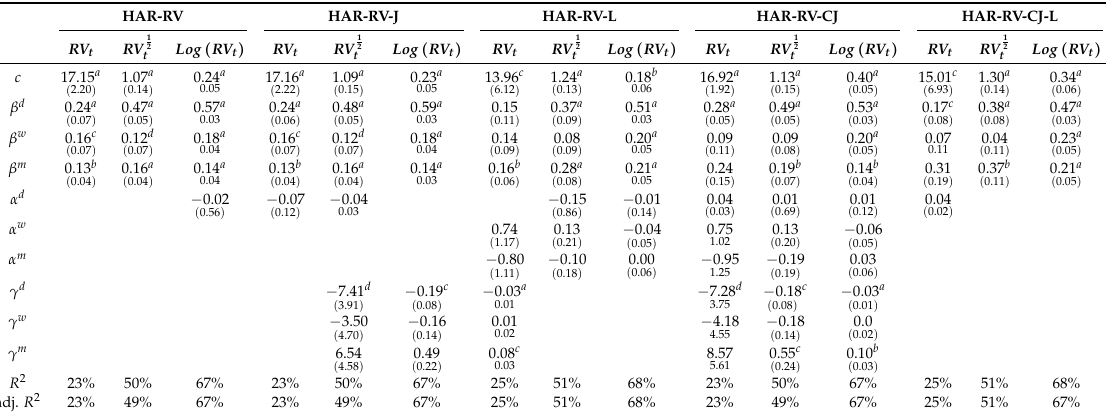
Table 6. OLS in sample estimated coefficients for the five different HAR models for Bitstamp (panel A) and Coinbase (panel B). HAC standard errors are reported in parentheses based on the Newey-West correction. The apexes a – d report the significance level, a = 0.1%, b = 1%, c = 5% and d =